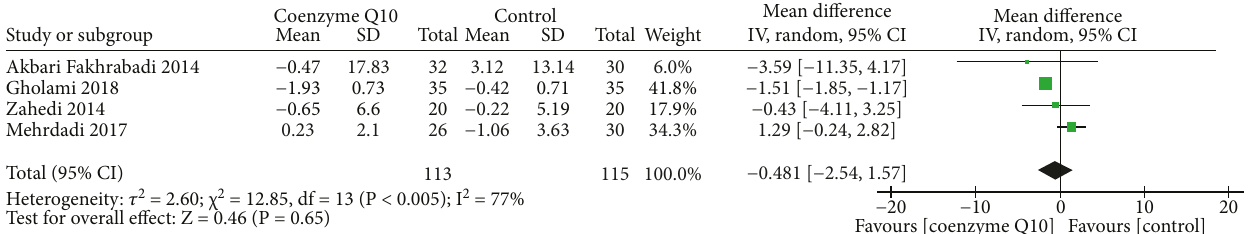
Figure 5: Fasting insulin.